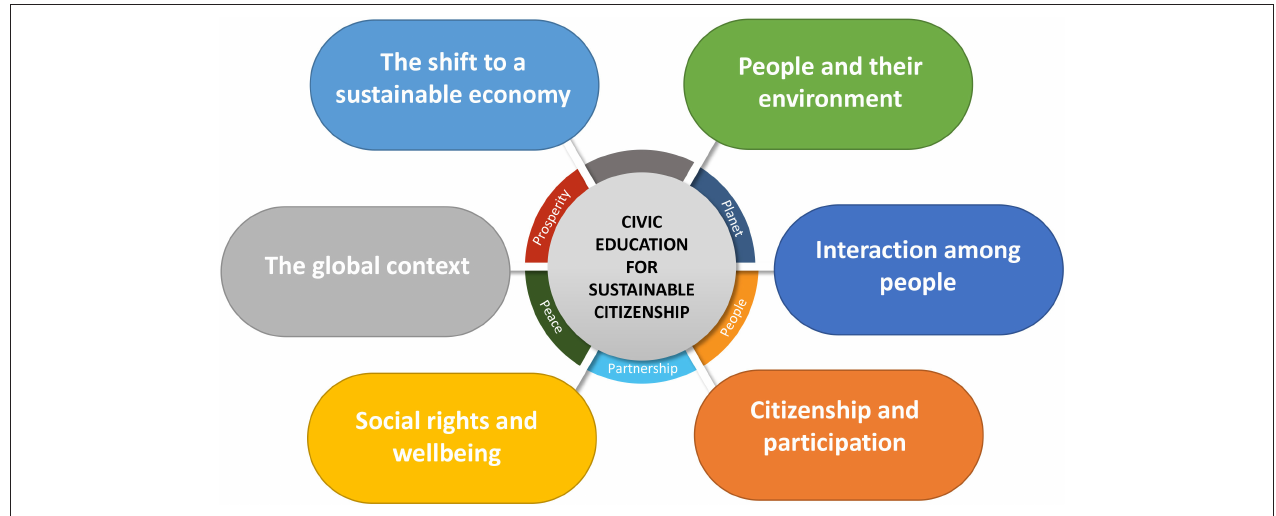
FIGURE 1 | Framework of education for sustainable citizenship.